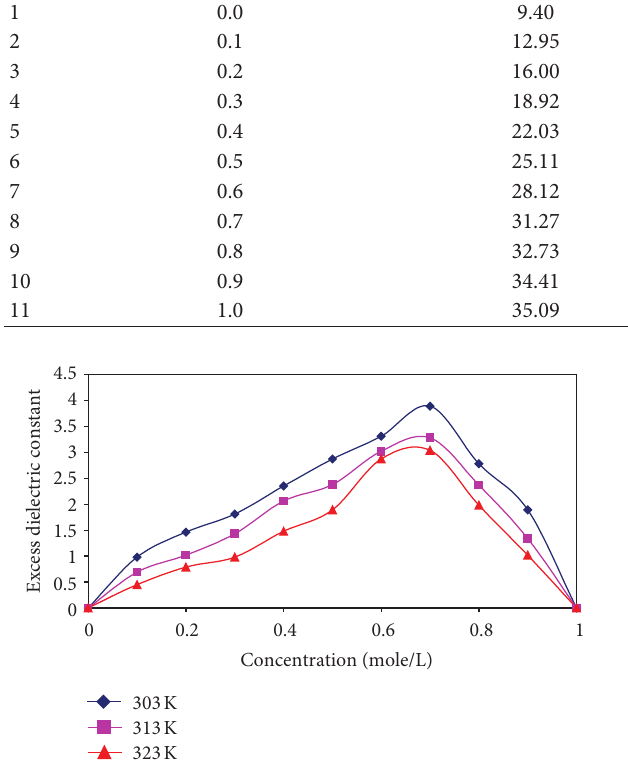
F 3: Excess dielectric constant for acetonitrile + methyl aminemixture versus concentration at 303, 313, and